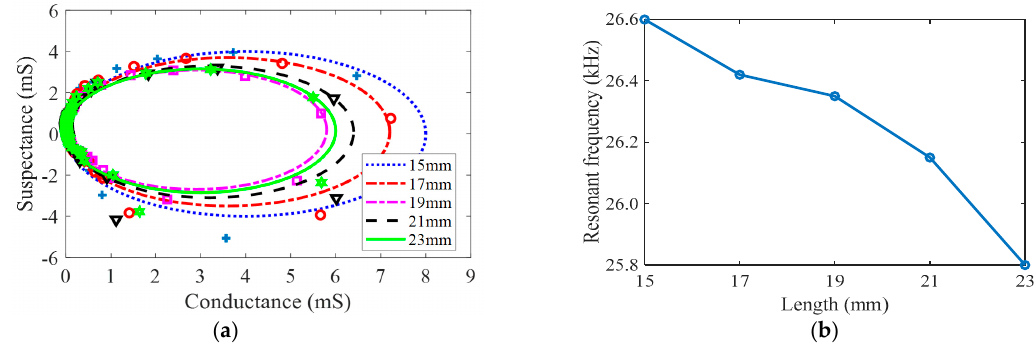
Figure 7. Admittance circle and resonant frequency with different lengths. ( a ) Admittance circle; ( b ) Resonant frequency.